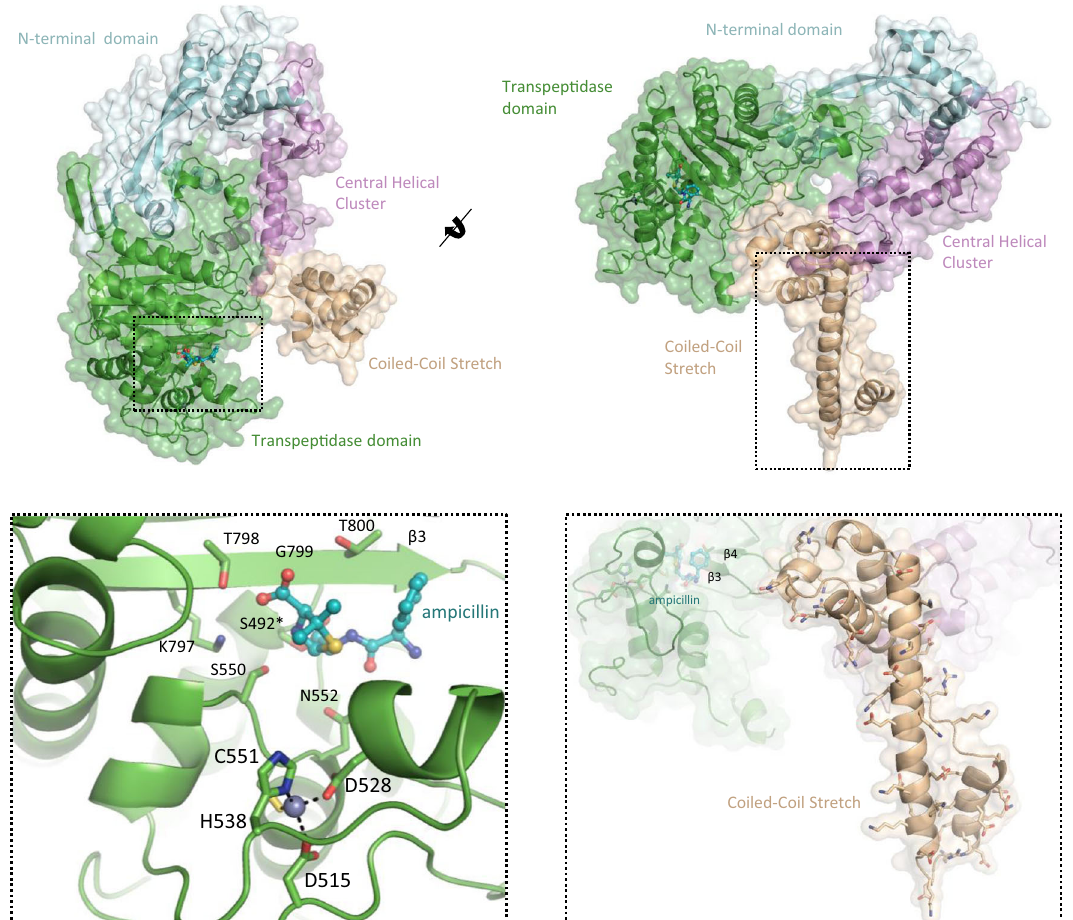
Fig.2|CrystalstructureofthePBP2-ampicillincomplex. Thecrystalstructureof PBP2 in complex with ampicillin at 3.0Å resolution reveals three novel structural features. This includes a novel Zn 2+ -binding motif in the active site (bottom left), a